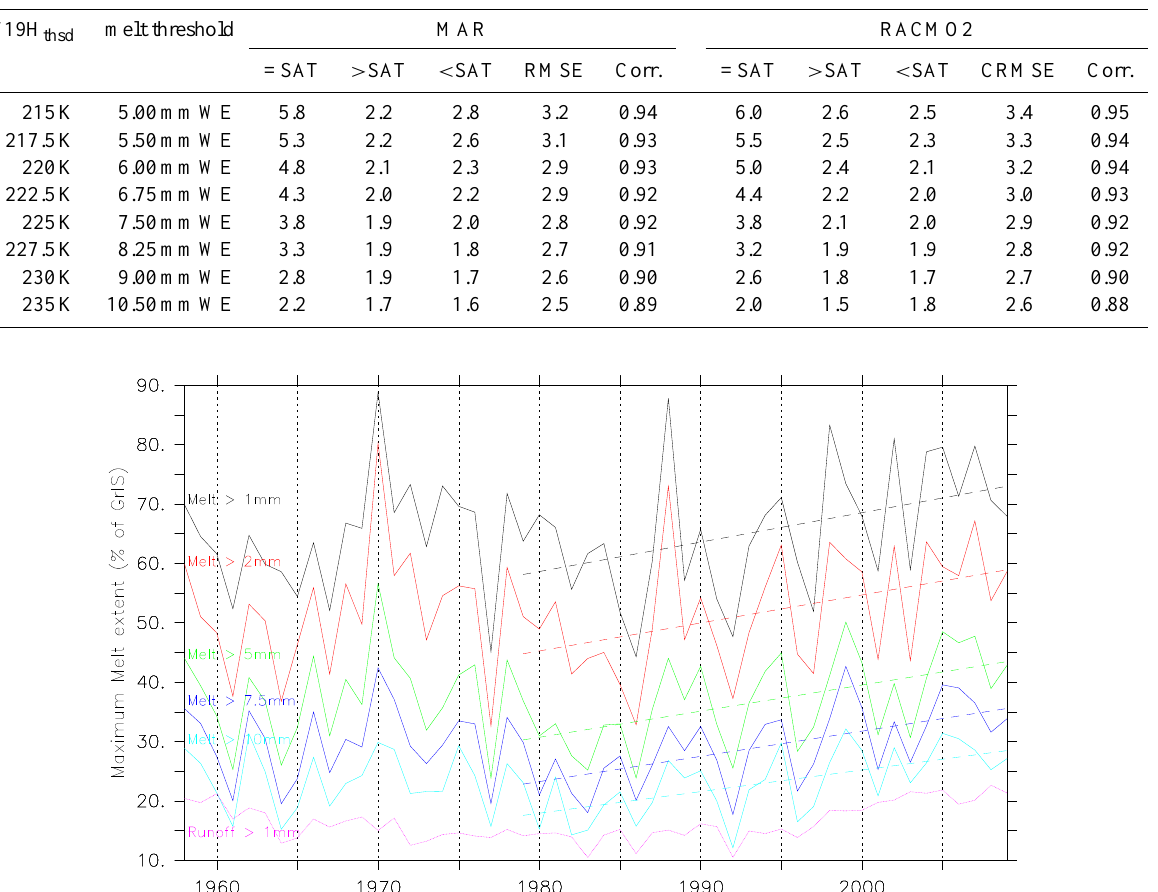
Table 4. Correspondence between Eq. (1)-based and RCM-based melt detection. The mean number of GrIS pixels when both RCM and T19H-based algorithms detect melt (RCM=SAT), when RCM detects melt and not the retrieving algorithms (RCM > SAT) and when RCM does not detect melt and well the T19H-based algorithms (RCM < SAT) is also listed in percent over the number of GrIS pixels × summer days. The remaining percent correspond to days where both RCM and T19H-based algorithms do not detect melt. The statistics (i.e. the mean correlation coefficient (Corr.) as well as the mean Root Mean Square Error (RMSE) over 1979–2009) between MAR/RACMO2 and the T19H-based GrIS melt extent time series are also listed.